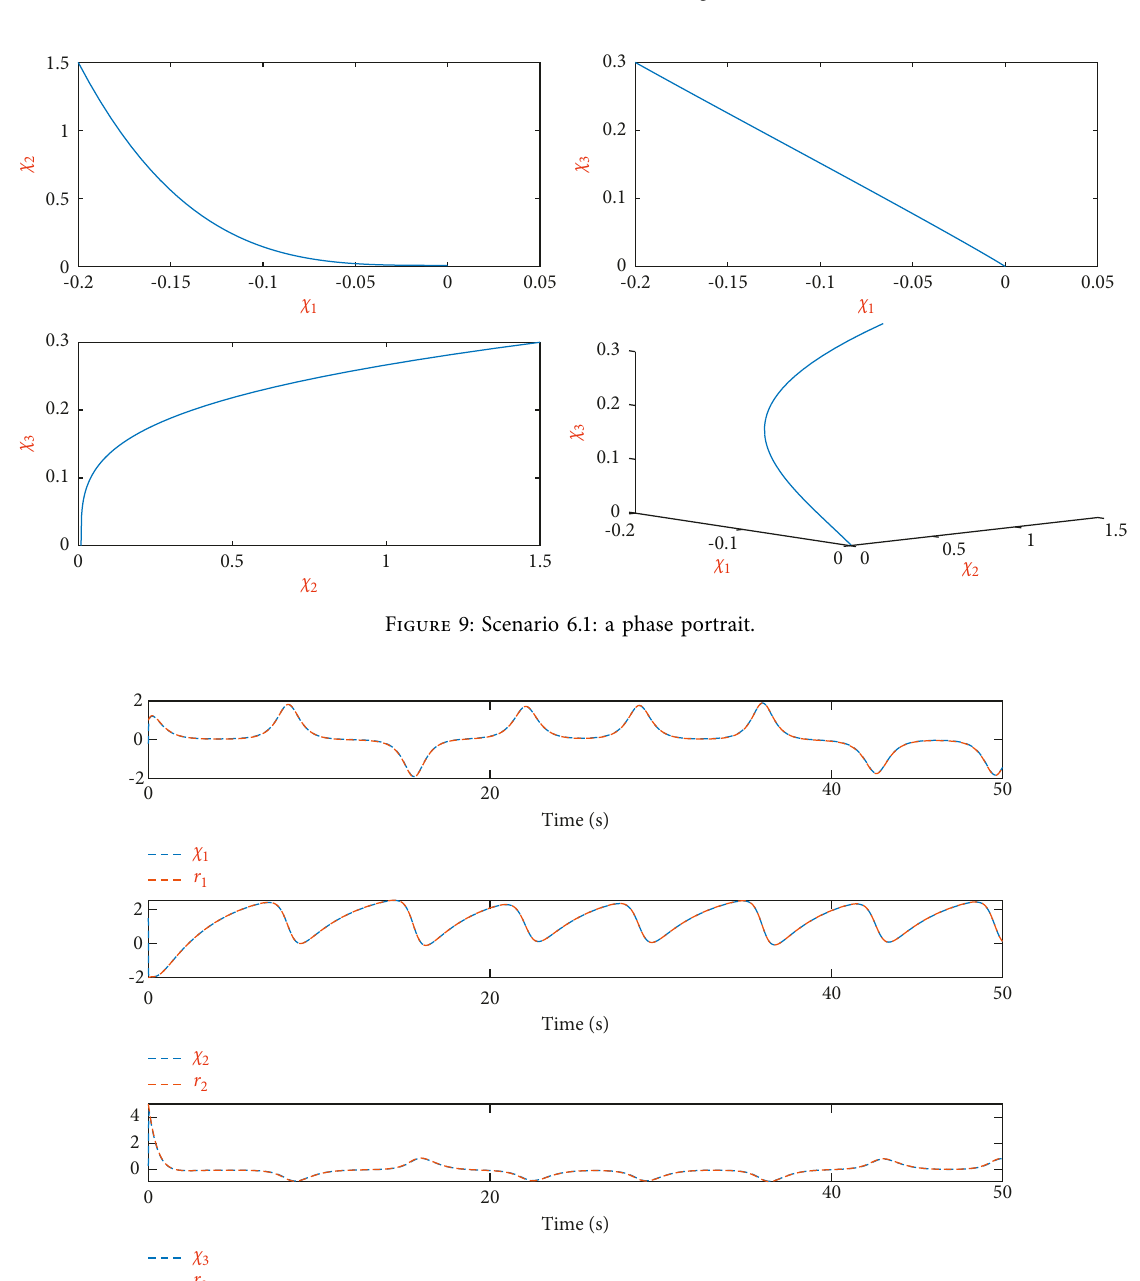
Figure 10: Scenario 6.2: output